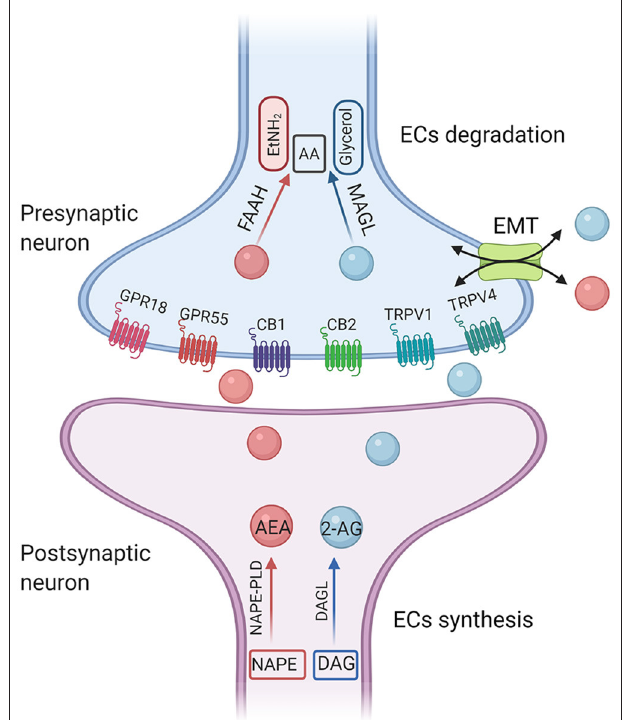
FIGURE 1 | A simplified illustration of endocannabinoid synthesis and degradation pathway. The diacylglycerol lipases (DAGL α and DAGL β ) hydrolyze DAG to generate 2-AG. DAGL- α is expressed on postsynaptic neurons within various brain regions. In contrast, DAGL- β is most highly expressed on microglia. 2-AG is preferentially degraded by monoglyceride lipase (MAGL). The main synthetase of AEA is N-acyl-phosphatidylethanolamine-phospholipase D (NAPE-PLD). The degradation enzyme of AEA is fatty amide hydrolase (FAAH). AEA, anandamide; 2-AG, 2-arachidonoyl-glycerol; CB1, cannabinoid receptor 1; CB2, cannabinoid receptor 2; TRPV1, transient receptor potential cation channel subfamily V member 1; GPRs, orphan G-protein-coupled receptors; AA, arachidonic acid; EtNH2, ethanolamine; EMT, extraneuronal monoamine